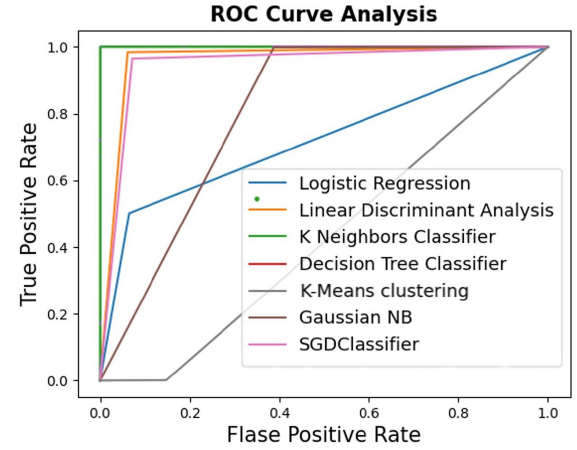
Figure 16. The ROC curves of ML models for Botnet.